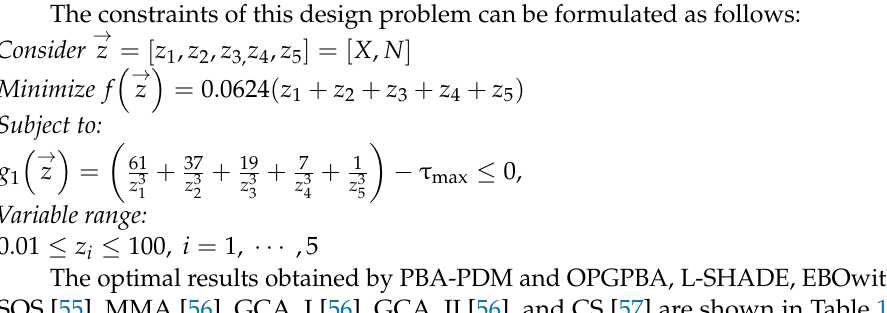
Table 19. It can be concluded that the solution obtained using PBA-PDM is very competi- tive and is better than all the other well-established comparison algorithms. Table 19. The comparison of PBA-PDM with other optimizers in Cantilever Beam Design. PBA-PDM